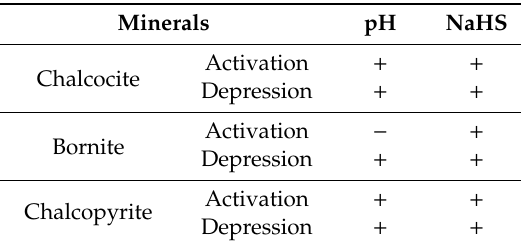
Figure 8. Chalcopyrite recoveries without NaHS and with NaHS dosages of 50 g/t, 100 g/t, and 200 g/t at ( a ) pH 8, ( b ) pH 9, and ( c ) pH 10. Table 5. The relationship between the minerals and the conditions of pH and NaHS dosage. “ + ” means positive correlation, “ − ” means negative